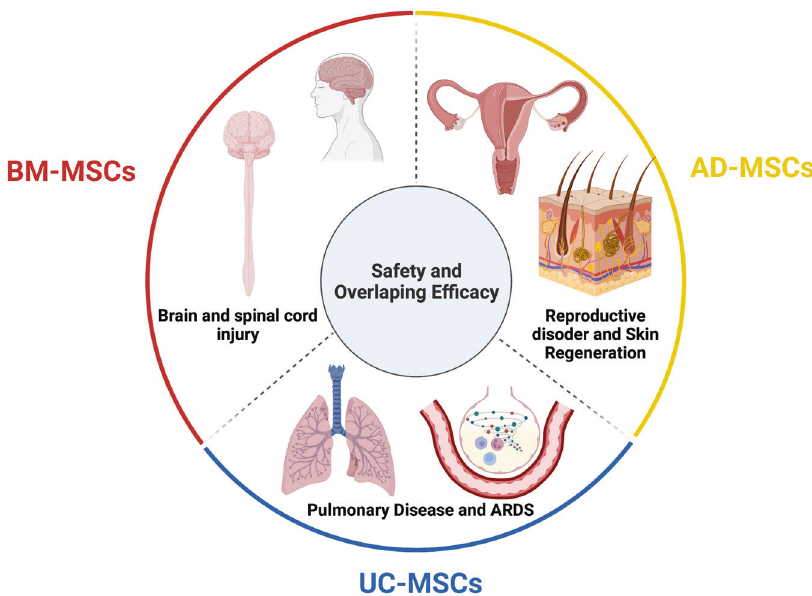
Fig. 6 The tissue sources of mesenchymal stem cells (MSCs) contribute greatly to their therapeutic potential, as all MSC types share safety pro fi les and overlapping ef fi cacy. Although a large body of data and their review and systematic analysis indicated the shared safety and potential ef fi cacy of MSCs derived from different tissue sources, targeted therapies considering MSC origin as an important factor are imperative to enhance the downstream therapeutic effects of MSCs. We suggest that bone marrow-derived MSCs (BM-MSCs) are good candidates for the treatment of brain and spinal cord injury, adipose tissue-derived MSCs (AT-MSCs) are suitable for the treatment of reproductive disorders and skin regeneration, and umbilical cord-derived MSCs (UC-MSCs) could be alternatives for the treatment of pulmonary diseases and acute respiratory distress syndrome (ARDS). Figure was created with